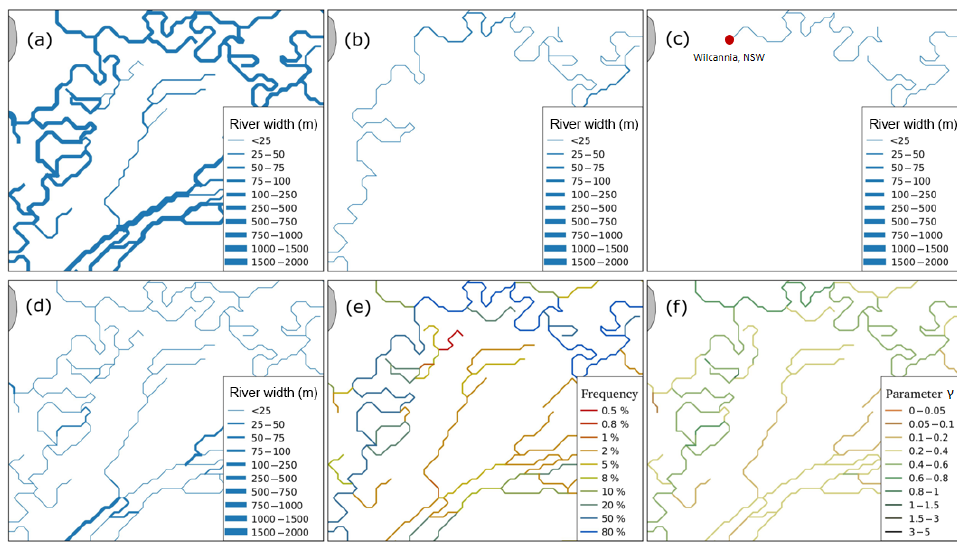
Figure 12. Illustration of data characteristics for an area including the Darling River and adjoining Talyawalka Creek near Wilcannia (NSW) (15.7 by 15.3km centred on 31.62 ◦ S, 143.42 ◦ E). Shown are (a) maximum river width (0.5% frequency); (b) median width (50%); (c) minimum river width (80%); (d) least detected river width and (e) corresponding frequency; and (f) hydromorphology parameter γ